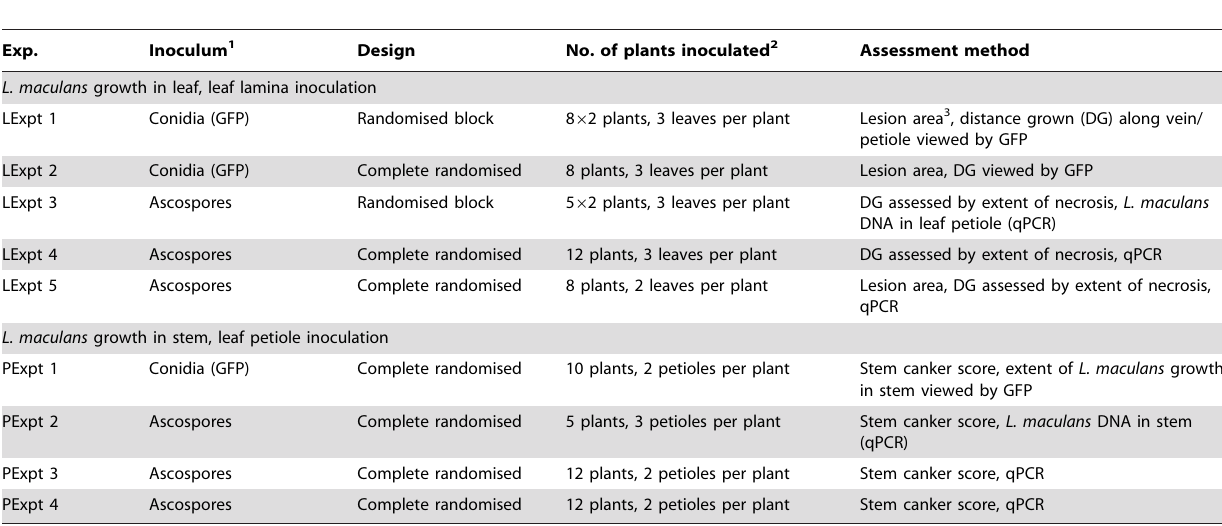
Table 1. Inoculation methods, type of Leptosphaeria maculans inoculum, number of plants inoculated, design of experiments and assessment methods used in each of the controlled environment experiments with the doubled haploid (DH) lines A30 or C119.